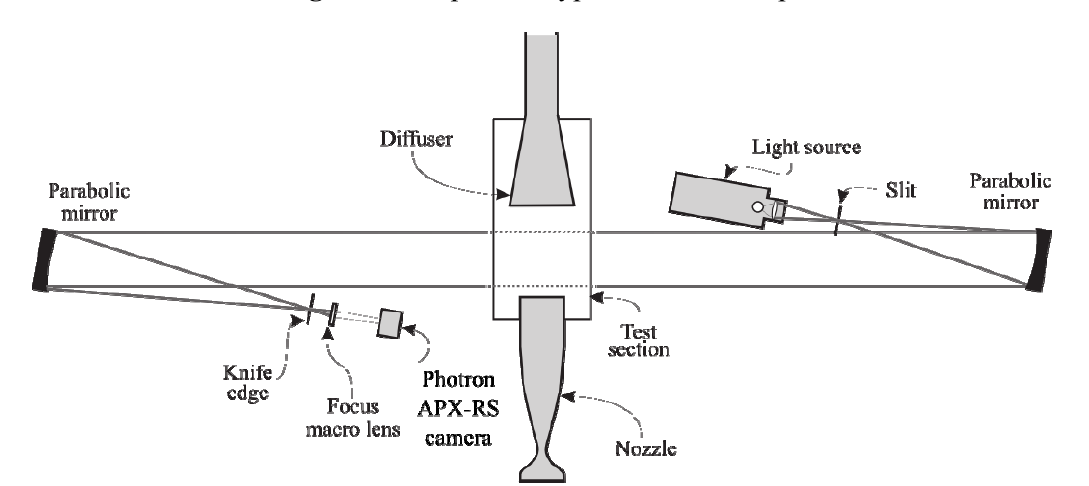
Figure 4. Toepler’s z-type Schlieren